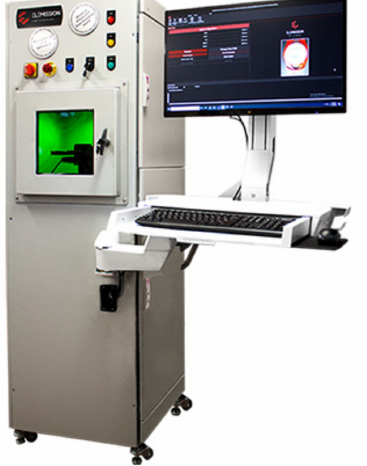
Figure 1. A CORIOSITY LIBS instrument by